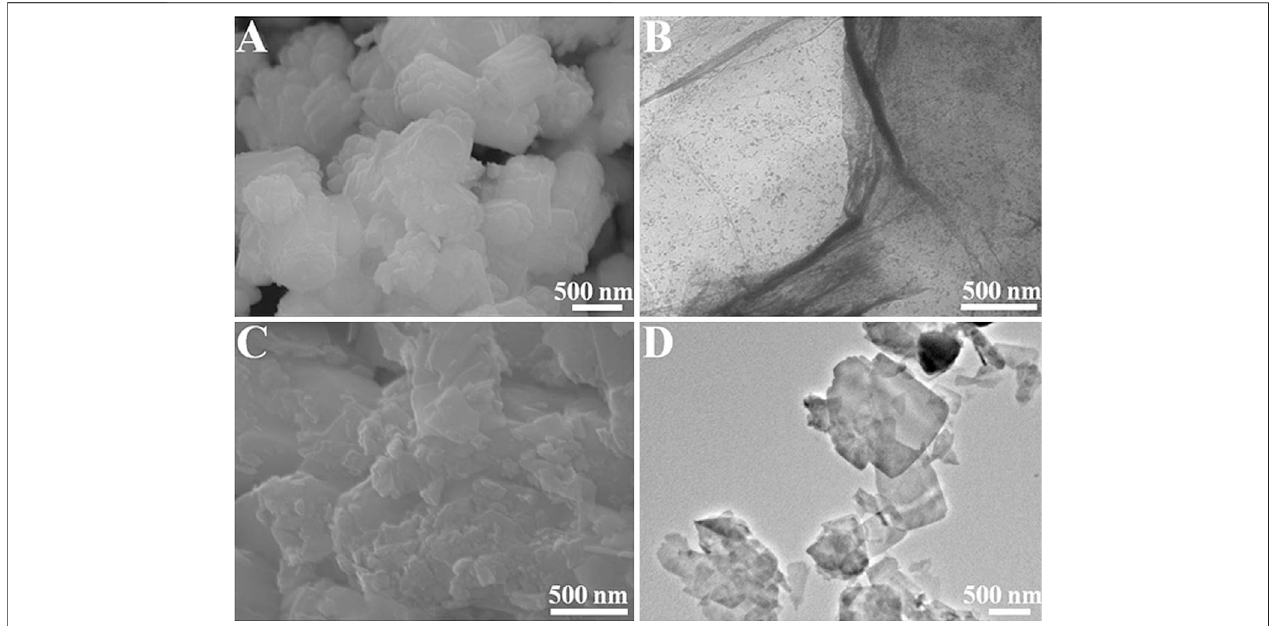
FIGURE 2 | (A) SEM image of NiCoPO 3 ; (B) Transmission electron microscopy image of GO; (C) SEM image of GO-NiCoPO 3 ; (D) Transmission electron microscopy image of GO-NiCoPO 3 . Go, graphene oxide; NiCoPO 3 , cobalt nickel phosphate.